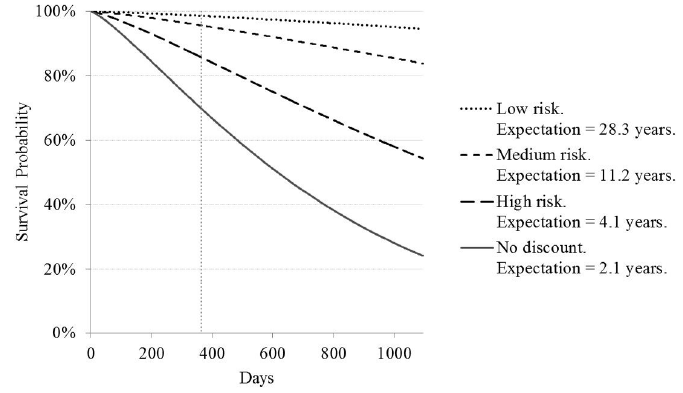
Figure 1. Survival curve for the time to the first accident at fault for all drivers.